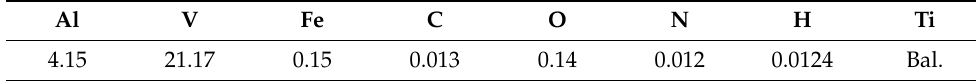
Table 1. Chemical composition of the Ti-22V-4Al (mass %).